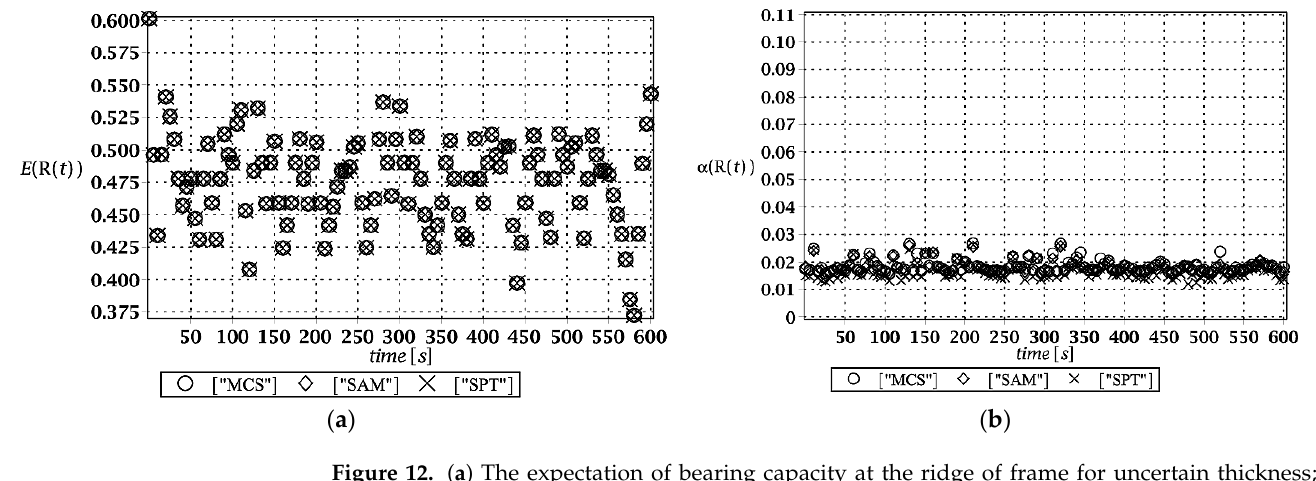
Figure 12. ( a ) The expectation of bearing capacity at the ridge of frame for uncertain thickness; ( b ) its CoV.